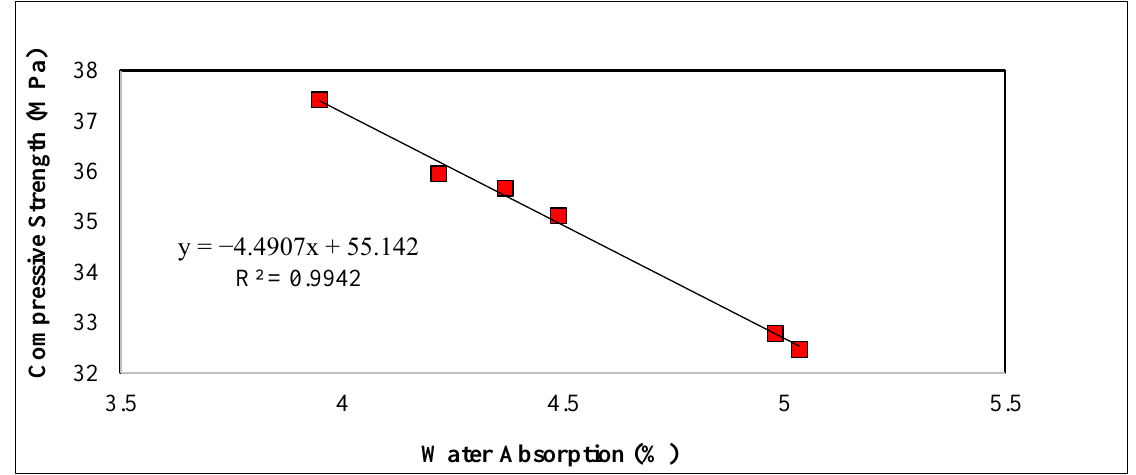
Figure 11. Correlation between compressive strength and water absorption.